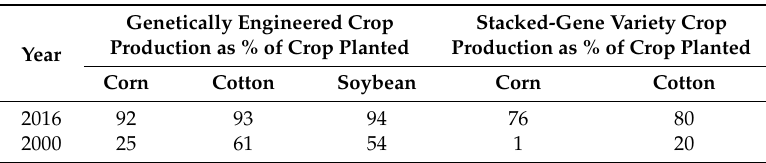
Stacked-Gene Variety Crop Production as % of Crop Planted